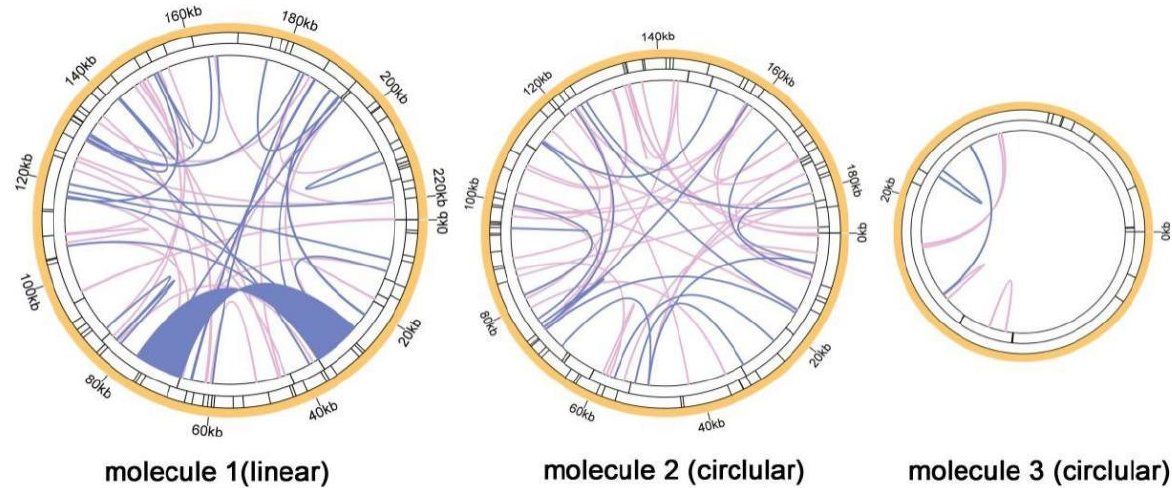
Figure 4. Q. acutissima mitogenome repeated sequence diagram. The colored line on the innermost circle connects two repeated sequences of interspersed repeats. The black line segments on the second circle and on the outermost circle denote tandem repeat and SSR, respectively.